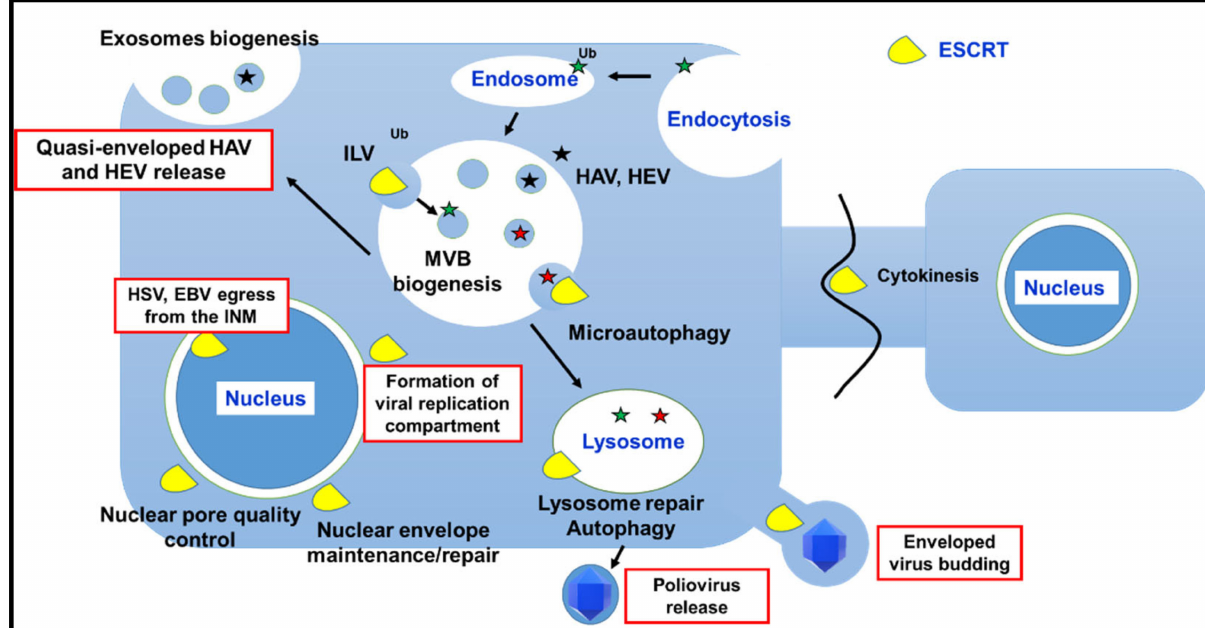
Figure 2. Schematic representation of the better-characterized cellular and viral processes (highlighted by red rectangles) that involve ESCRT-machinery or specific ESCRT factors. HAV stands for hepatitis A virus; HEV for hepatitis E virus; HSV for herpes simplex virus; EBV for Epstein–Barr virus; INM for inner nuclear membrane. The involvement of ESCRT machinery in the viral replication cycles is discussed in the next